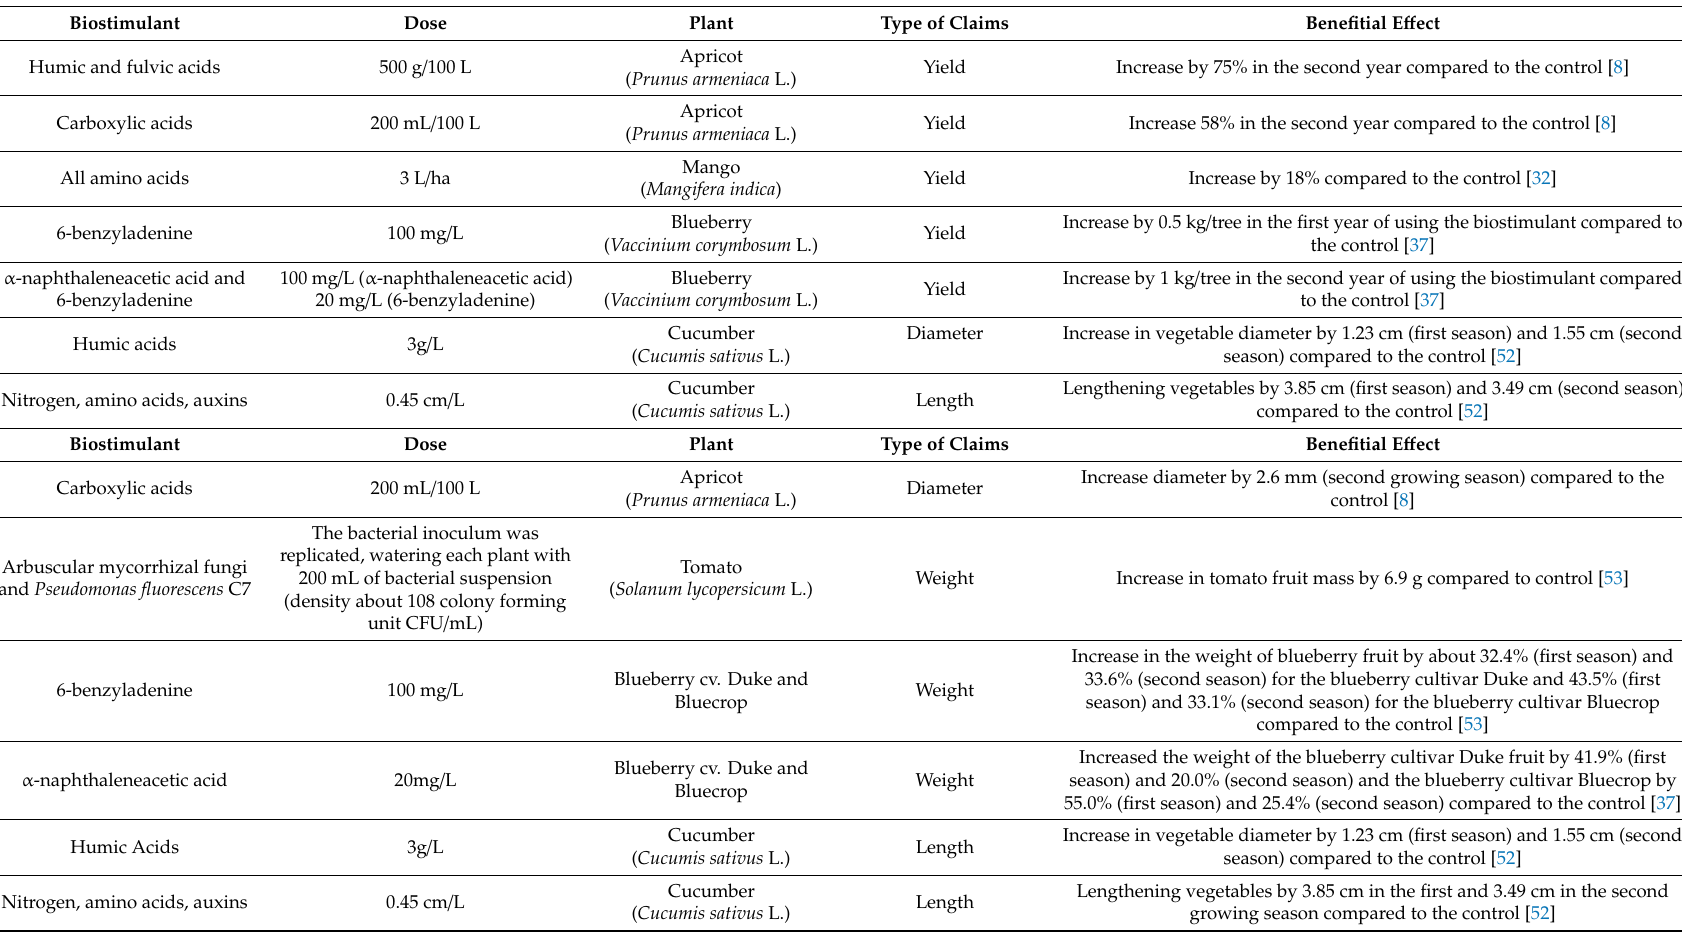
Table 2. E ff ect of selected biostimulants on quality of fruit and